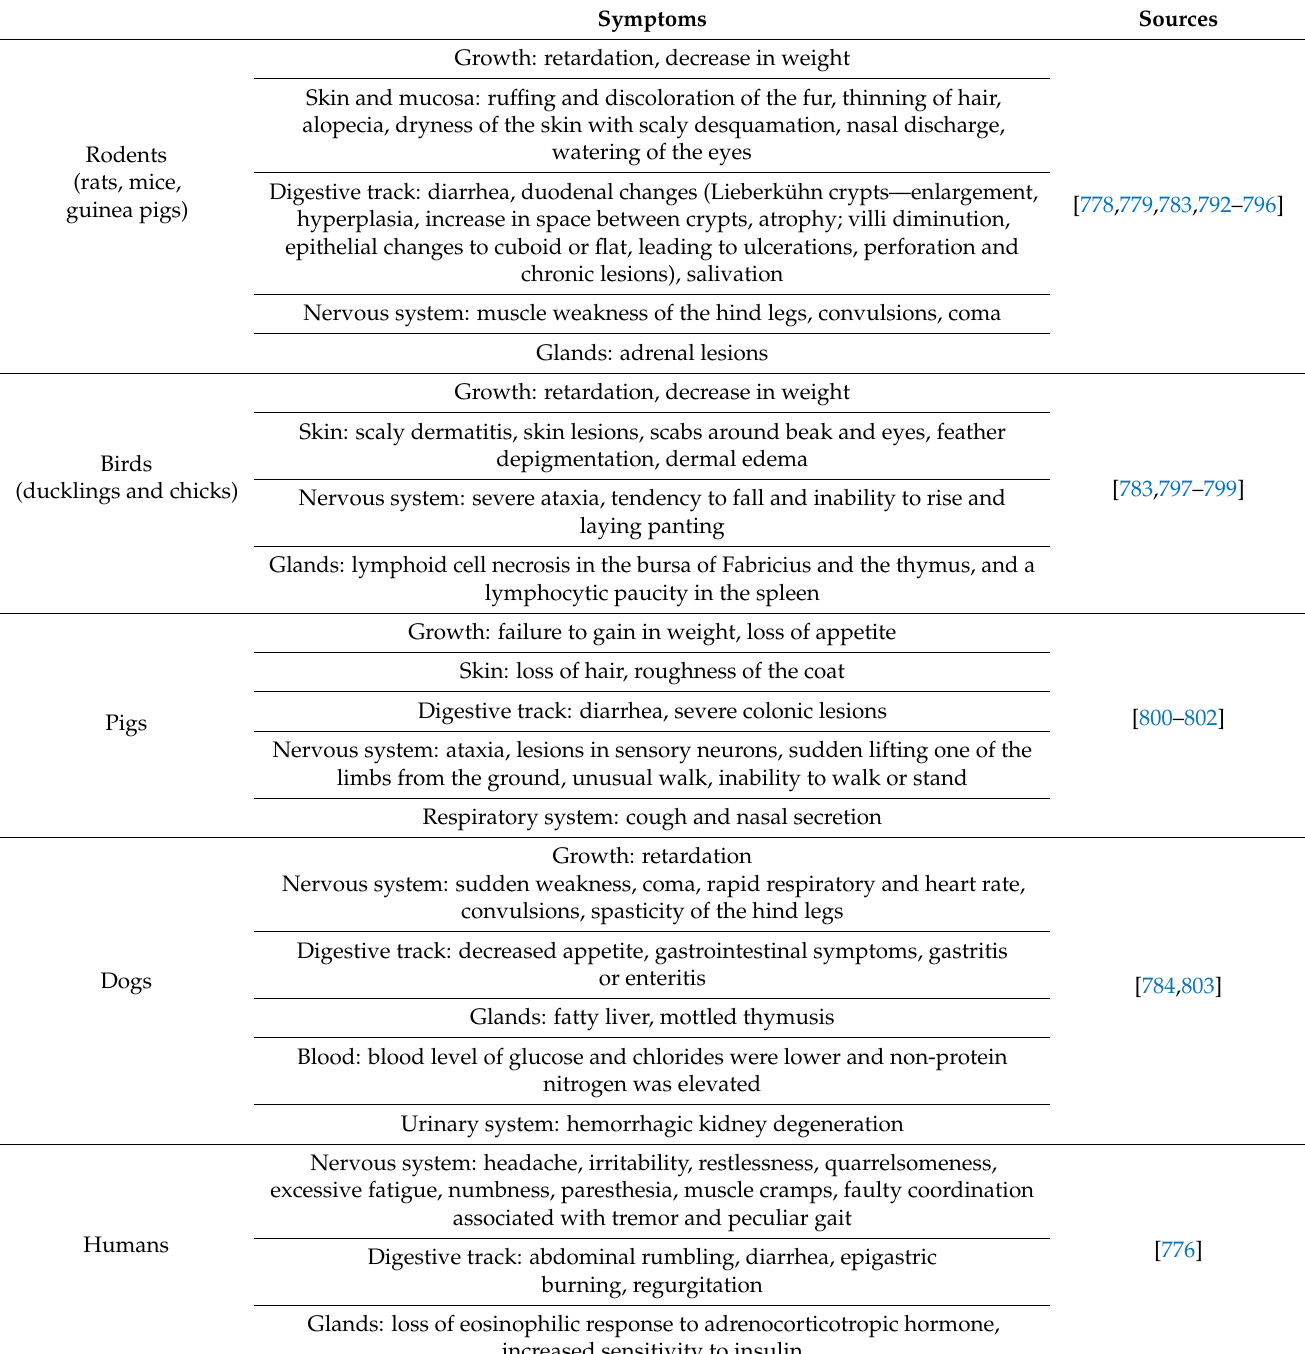
Table 11. Symptoms of pantothenic acid